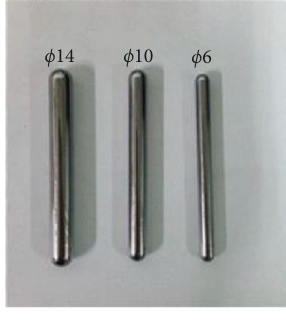
Figure 5: Forming tool.